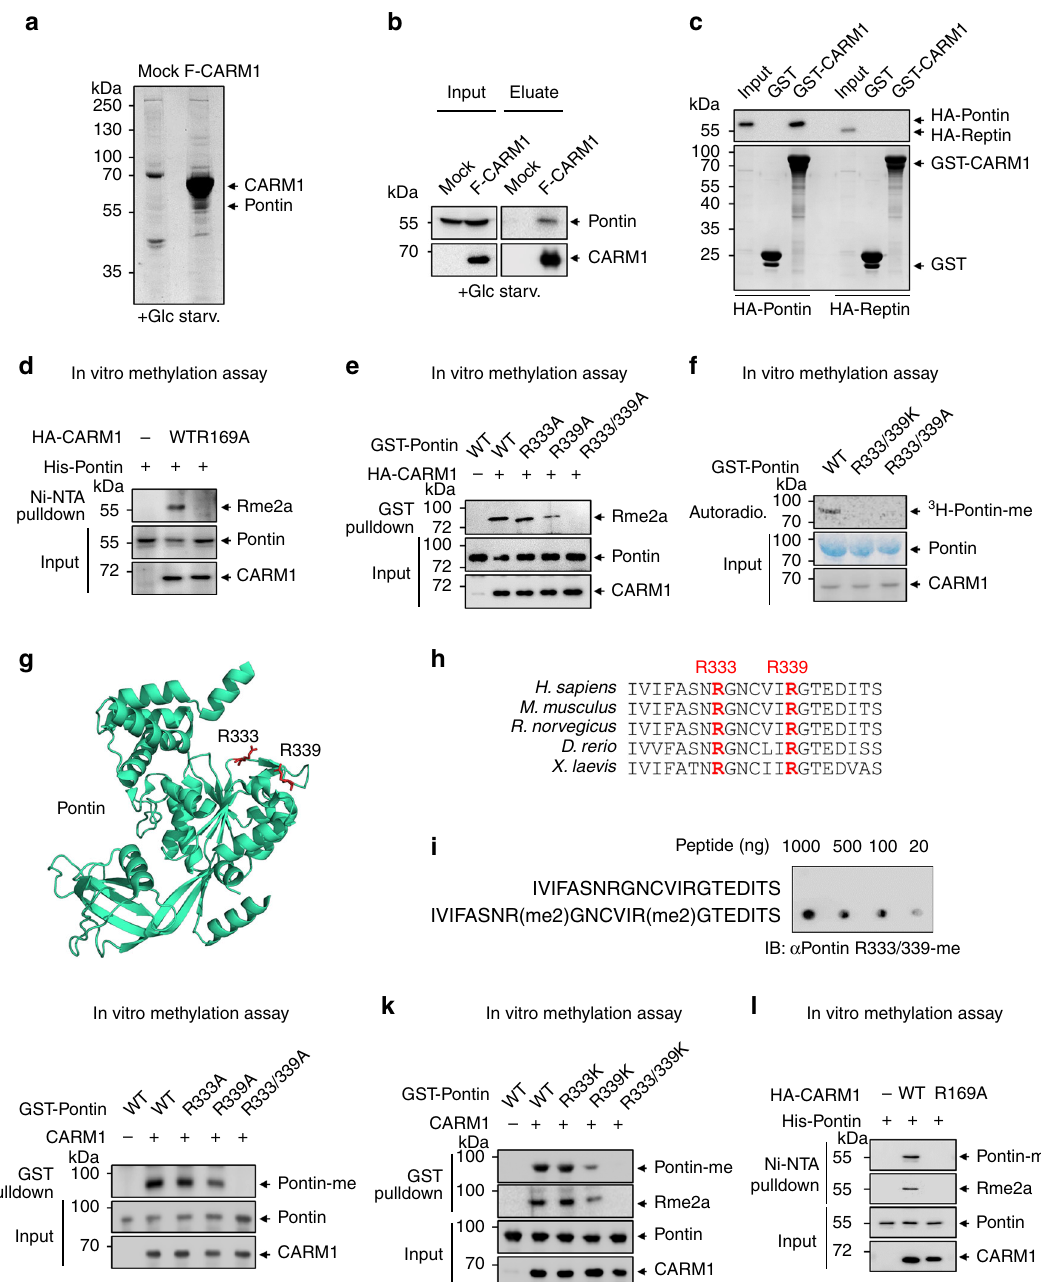
Fig. 1 Pontin is arginine methylated by CARM1 at R333 and R339 residues. a CARM1-interacting proteins were puri fi ed from HEK293T cells stably expressing Flag-CARM1 by co-immunoprecipitation with Flag-M2 agarose. Mass spectrometric analysis identi fi ed Pontin as a CARM1-interacting protein under glucose starvation. b The binding of Pontin to CARM1 was detected from the eluate of af fi nity chromatography by immunoblot analysis. c GST- pulldown assay for binding of CARM1 to Pontin and Reptin. d In vitro methylation assay using puri fi ed His-Pontin was performed with either HA-CARM1 WT or enzymatic activity-de fi cient R169A mutant. Immunoblotting with anti-asymmetric dimethyl arginine (Rme2a) antibody was performed after Ni-NTA pulldown. e In vitro methylation assay using puri fi ed GST-Pontin WT, R333A, R339A, or R333/339A mutant with HA-CARM1. Immunoblot analysis with anti-Rme2a antibody was performed after GST pulldown. f In vitro methylation assay of Pontin WT, R333K/R339K mutant, or R333A/R339A mutant proteins was performed with CARM1 proteins. g Ribbon diagram of Pontin (PDB 2C9O) showing its structure with R333 and R339 residues. h Sequence alignment of human Pontin with selected homologs. Conserved arginine residues (R333/R339) are highlighted with red. i The speci fi city of antibodies against methylated Pontin at R333/R339 residues was assessed by dot blot analysis. Methyl peptide sequence: IVIFASNR(me2)GNCVIR(me2)GTEDITS; Non-methyl peptide sequence: IVIFASNRGNCVIRGTEDITS. j In vitro methylation assay using puri fi ed GST-Pontin WT, R333A, R339A, or R333/339A with CARM1. Immunoblot analysis with anti-methyl-Pontin antibody was performed after GST pulldown. k In vitro methylation assay using puri fi ed GST-Pontin WT, R333K, R339K, or R333/339K proteins with CARM1. Immunoblot analysis with anti-methyl-Pontin and anti-Rme2a antibody was performed following GST pulldown. l In vitro methylation assay using puri fi ed His-Pontin with HA-CARM1 WT or R169A. Immunoblot analysis with anti-methyl-Pontin antibody was performed after Ni-NTA pulldown. Source data are provided as a Source Data fi